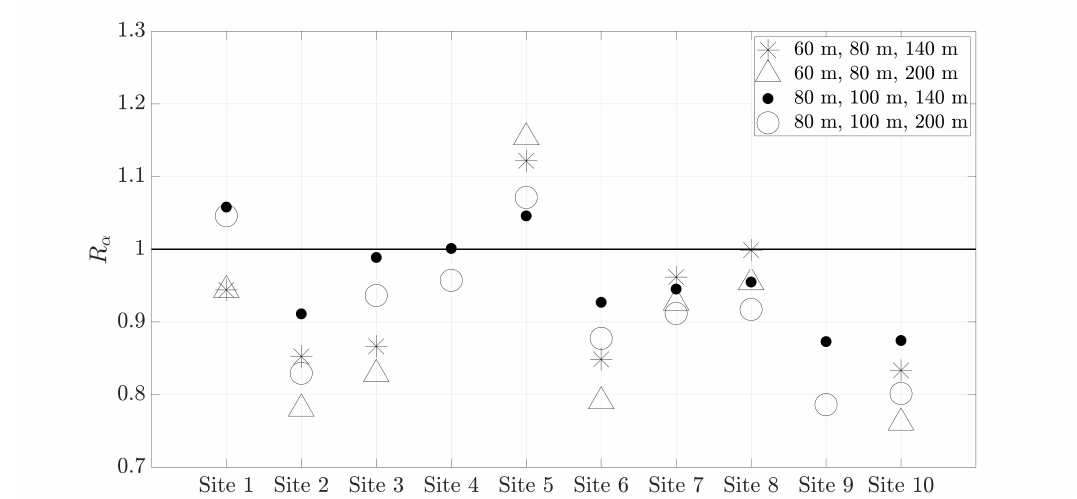
Figure 3. Height dependence of the power law exponents expressed by using the quantity R α . Shown for four different combinations of z 1 , z 2 and z t using annual mean wind speeds. Note that, at Site 4 and Site 9, no measurement data at the 60 m level were available (see Table